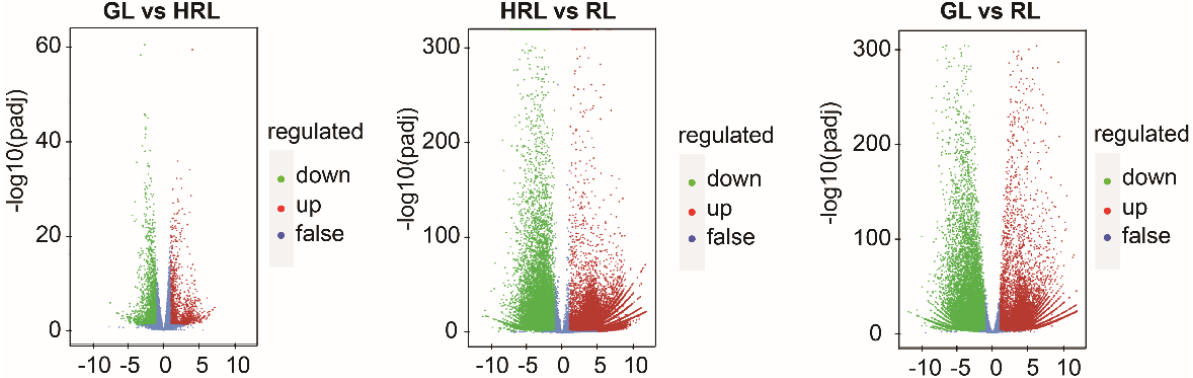
Figure 4. Volcano plots of differentially expressed genes; green, red, and blue dots represent the downregulated, the upregulated, and non ‐ differentially expressed genes, respectively.